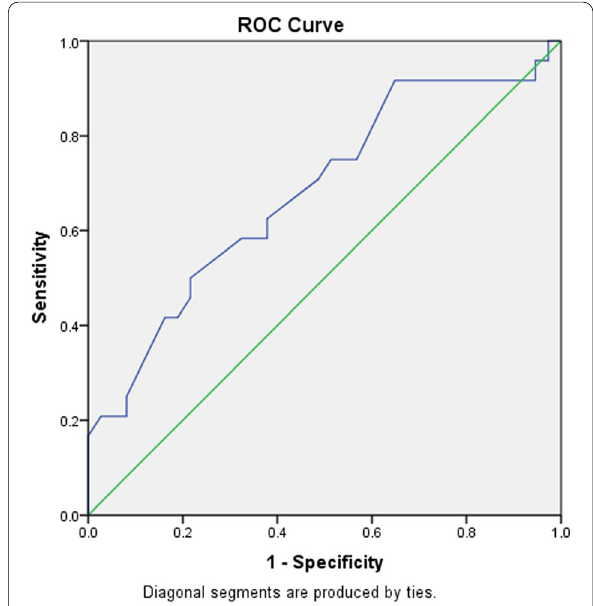
Fig. 4 ROC curve of urethral plate/penile length